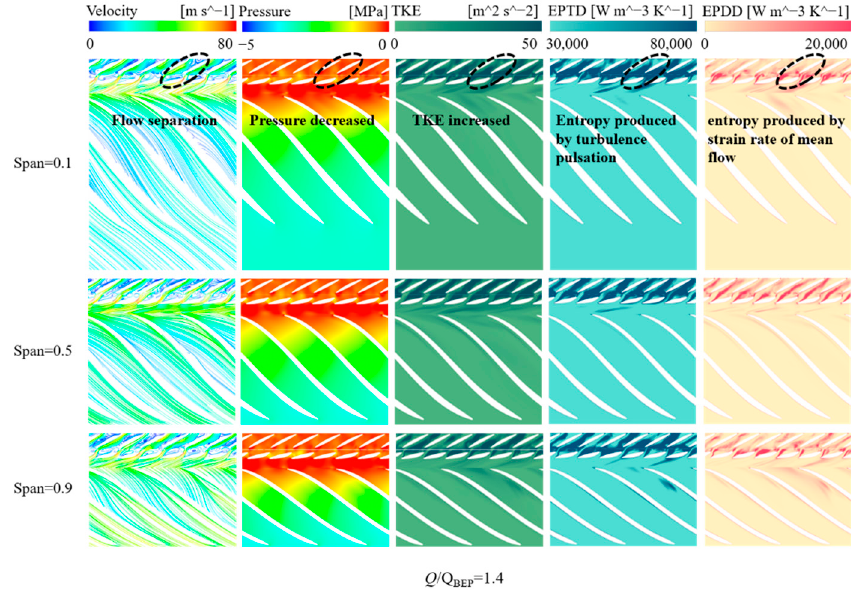
Figure 11. Entropy production distribution under high-flow conditions (1.4Q BEP ).